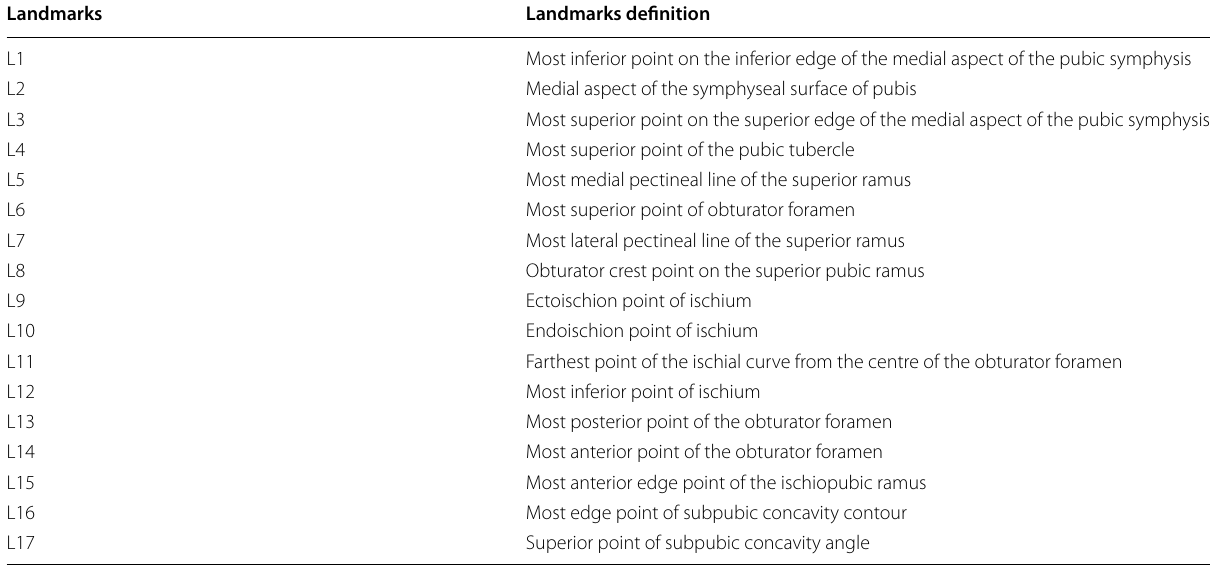
Table 1 Landmark points definition